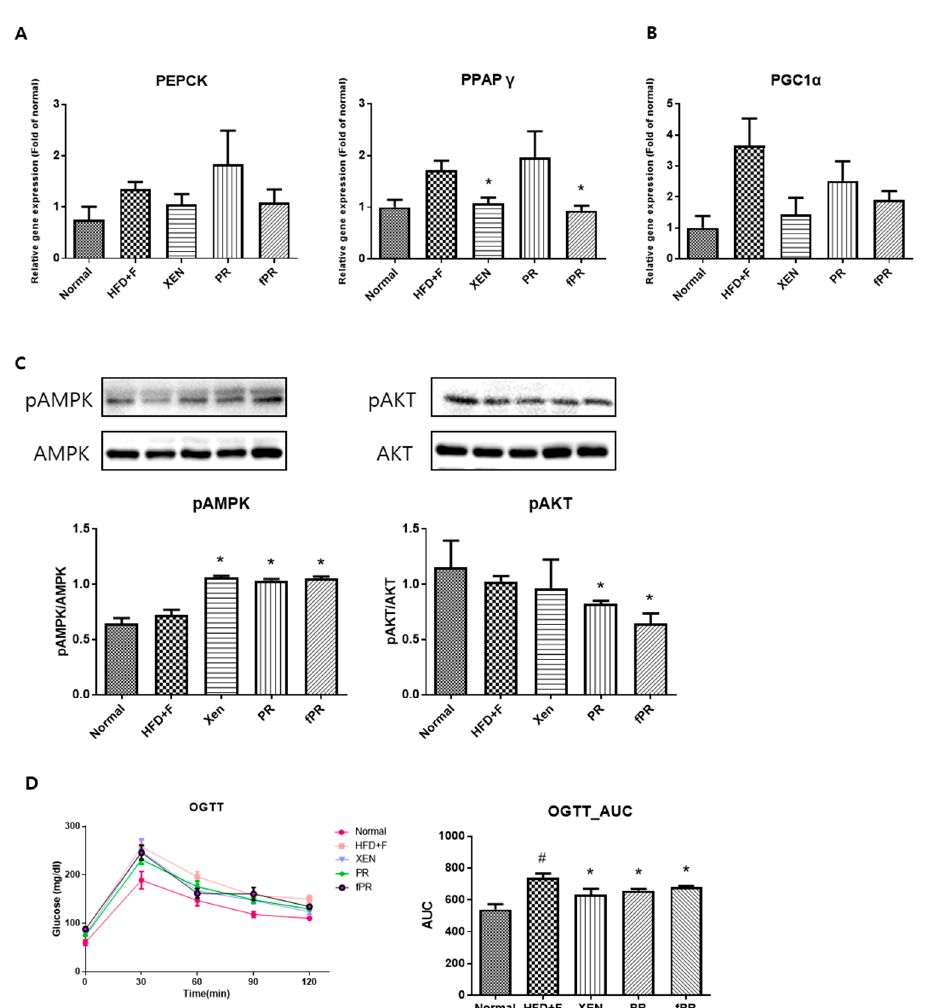
Figure 4. To confirm the e ff ects of the herbal treatments on gluconeogenesis, gene expressions of key factors in the metabolic processes were assessed in hepatic and intestinal tissues. ( A ) Expressions of the PEPCK and PPAR γ genes in the liver tissue, and ( B ) expression of the PGC1a gene in the intestinal tissue. ( C ) Phosphorylation of the AMPK and AKT proteins in the liver. ( D ) Results of the oral glucose tolerance test (OGTT) performed on the mice in the last week of the study. Areas under the curve (AUCs) were constructed as described in the ‘Materials and Methods’ section. Data are expressed as means ± SD and were evaluated using one-way ANOVA. # p < 0.05 compared to the normal group; * p < 0.05 compared to the HFD + F-fed group.